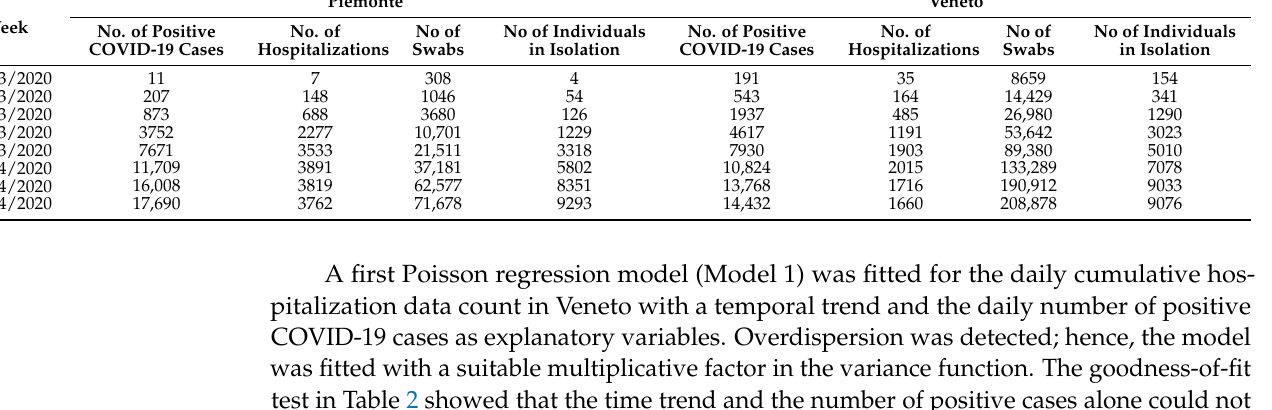
Table 2. Goodness-of-fit and prediction accuracy indexes. The goodness-of-fit indexes were